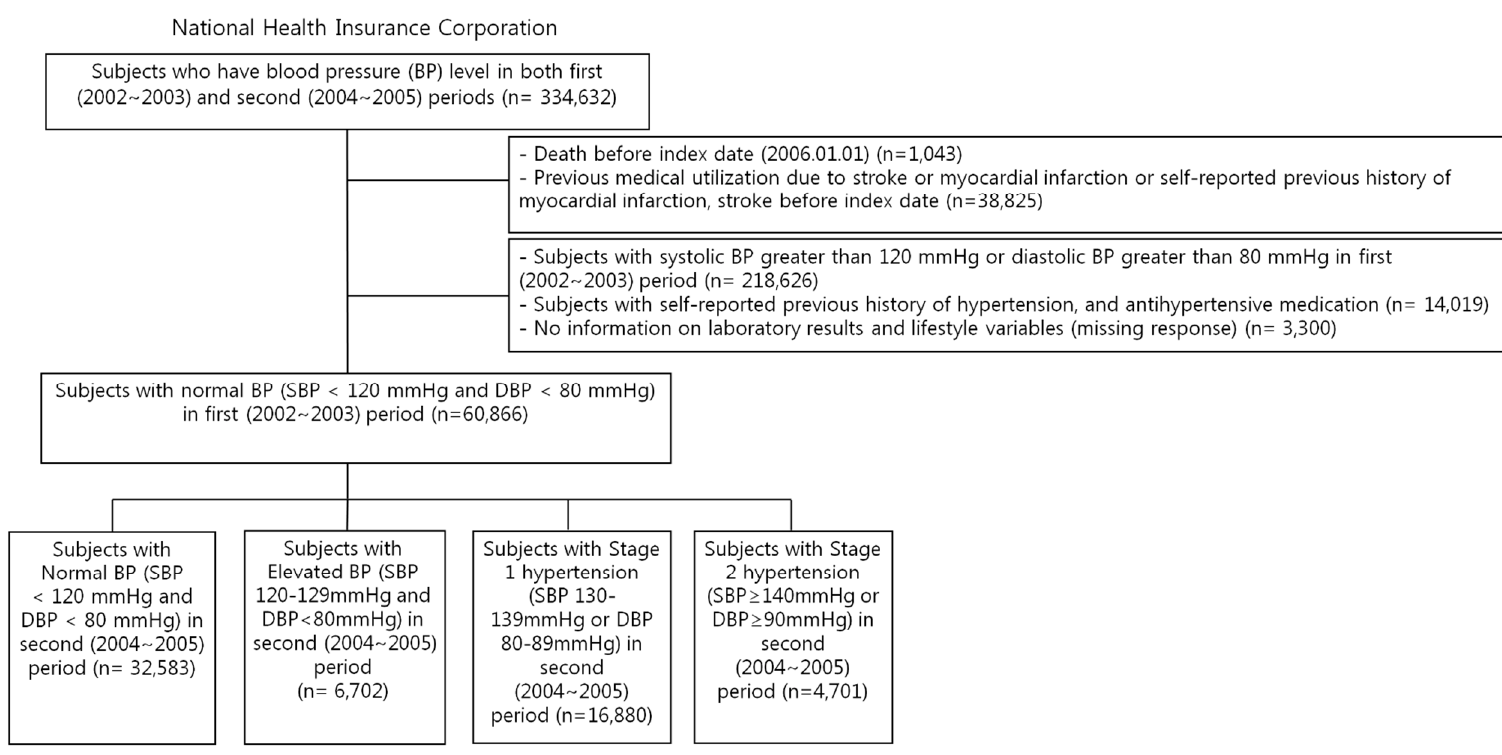
Figure 1. Flow chart of the study population.